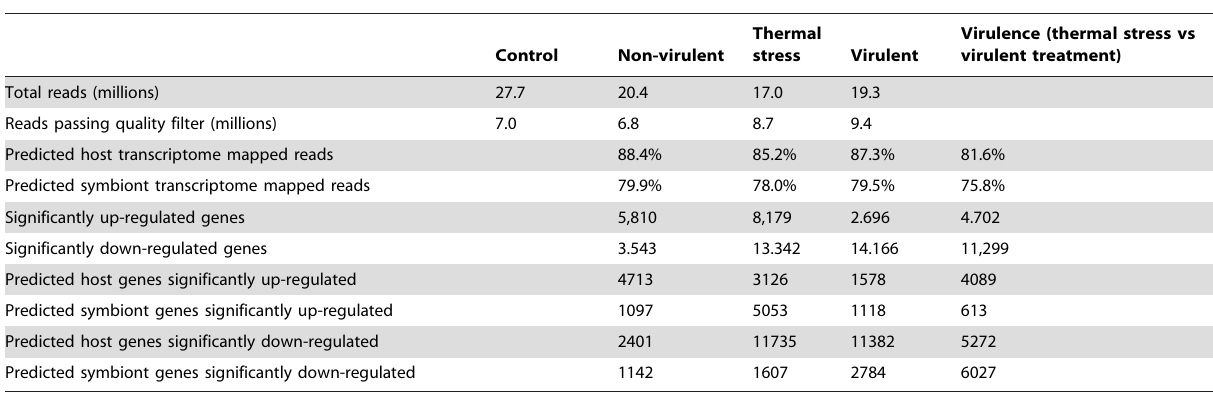
Table 1. Sequencing, filtering and gene expression